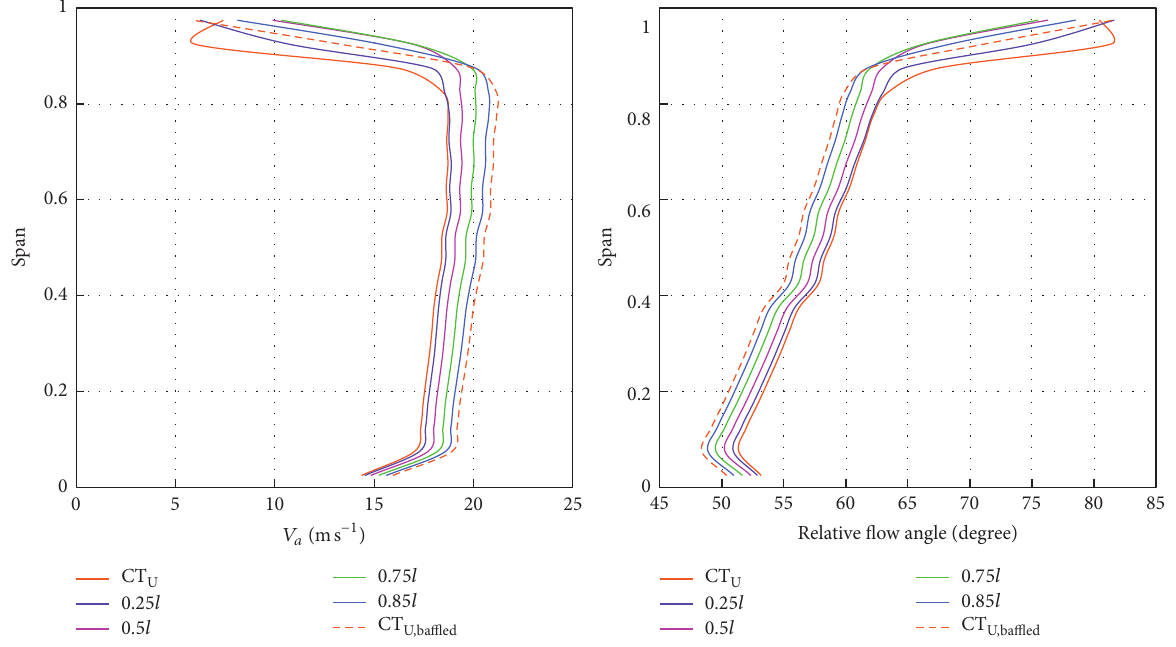
Figure 16: The distribution of inlet velocity for different baffle lengths at 𝑚 = 3.4